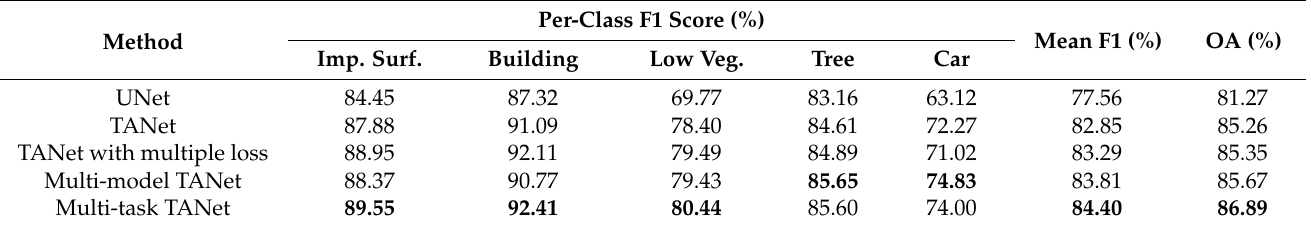
Table 5. F1 score, Mean F1, and OA index results of different models (Vaihingen dataset).